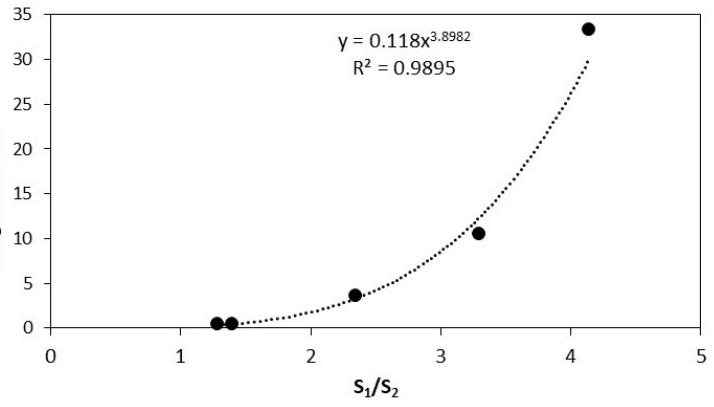
Figure 7. Relationship between drag coefficient and the area ratio from flume numerical, S1 corre- sponds to the flow area upstream and S2 corresponds to the flow area above the sand nest